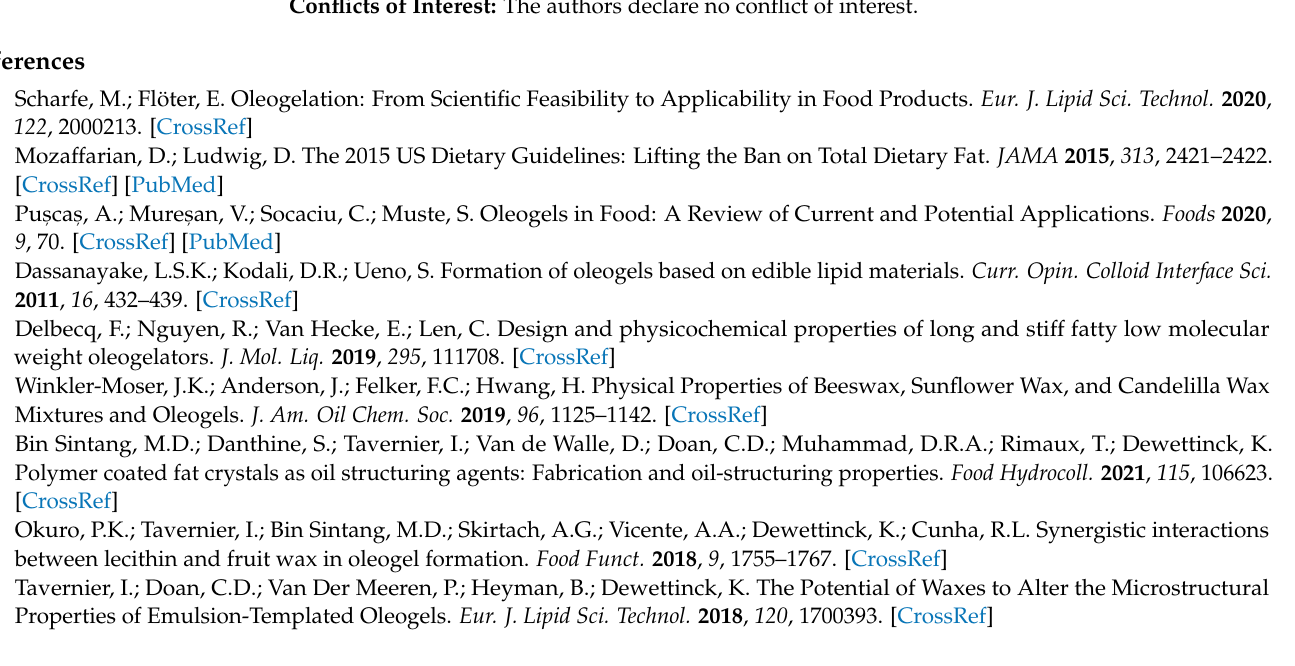
profile of a) SPAN-80 formulation b) TWEEN-80 formulation. Table S2: Parameters of spreadability test of oleogel. Figure S2: FTIR spectra of raw components and control oleogel. Figure S3: FTIR spectra all the formulations. Table S3: Thermal properties of